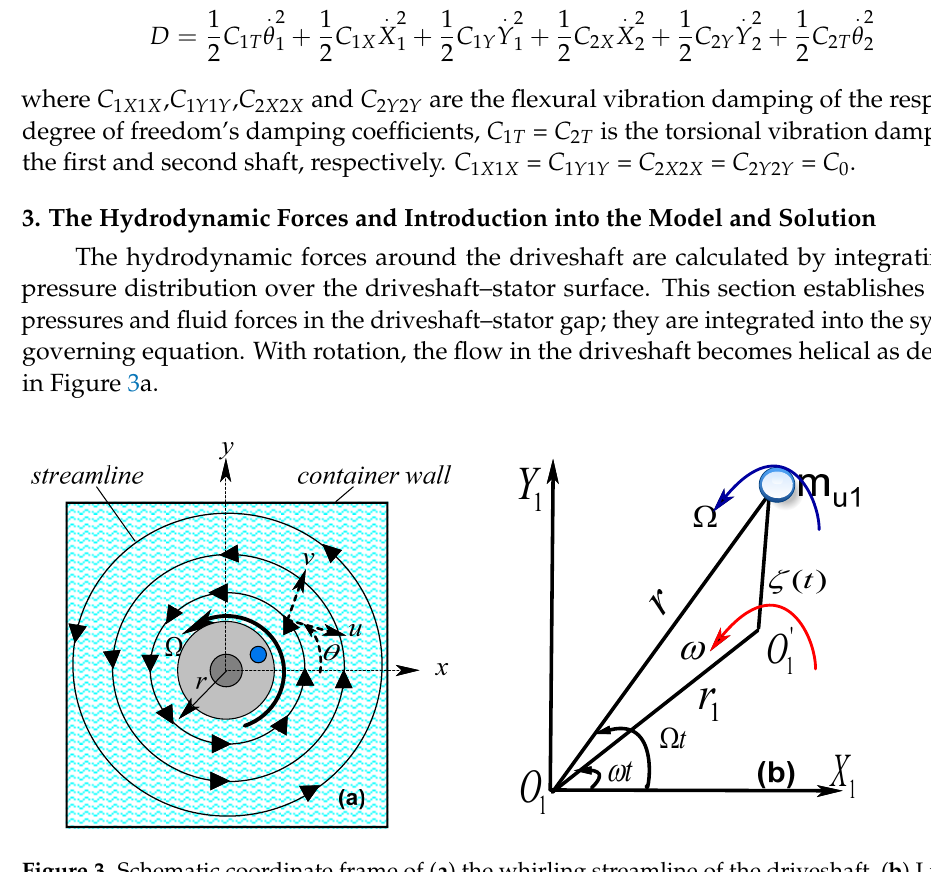
Figure 3. Schematic coordinate frame of ( a ) the whirling streamline of the driveshaft, ( b ) Lumped mass point.